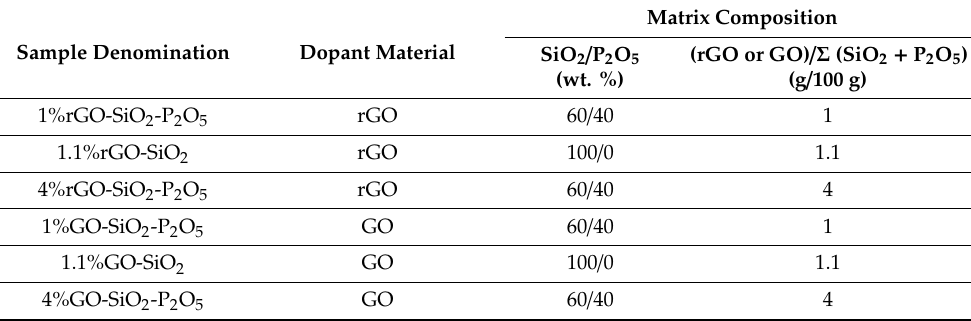
Table 1. Composition and denomination of